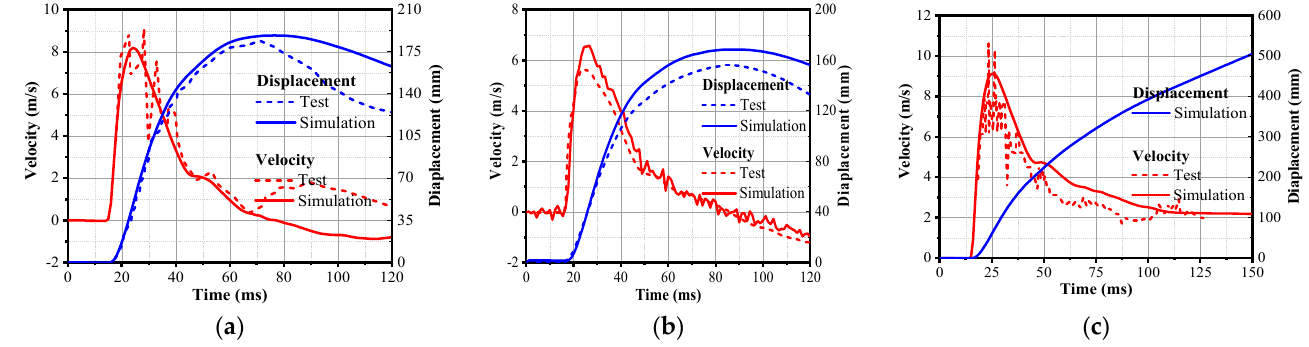
Figure 5. Velocity- and displacement-time histories in Test 1 at measuring point: ( a ) L1; ( b ) A1; ( c )